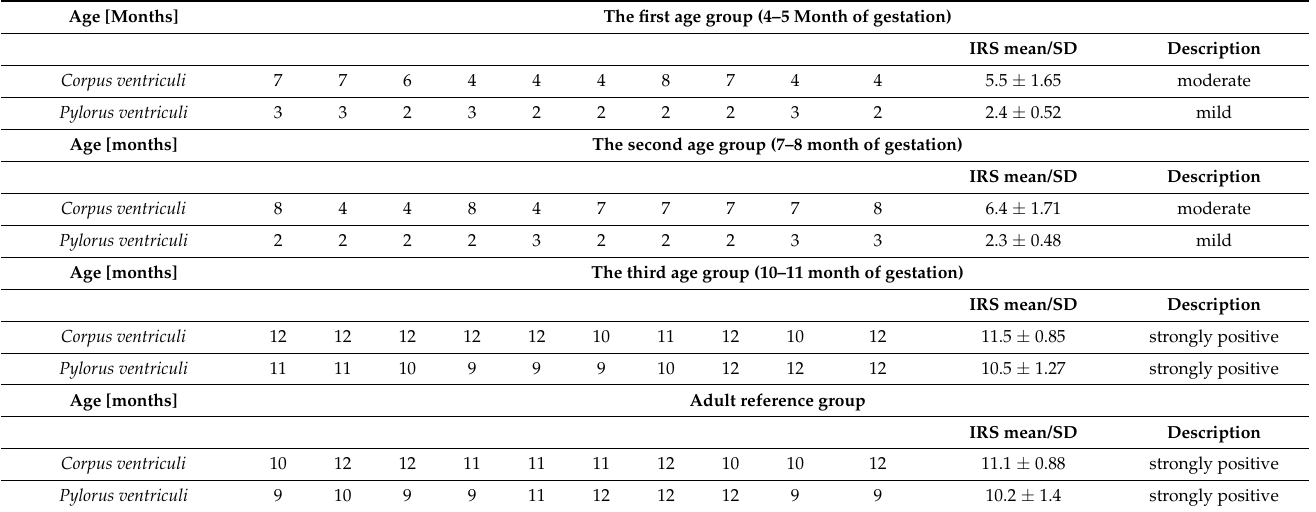
Figure 4. Immunoreactivity of anti-gastrin antibody in the pyloric mucosa of the stomach, 40×. ( A ) the first age group, ( B ) the second age group, ( C ) the third age group, ( D ) adult reference group. The arrow indicates positive immunohistochemical reaction. Table 3. Immunoreactivity of anti-gastrin